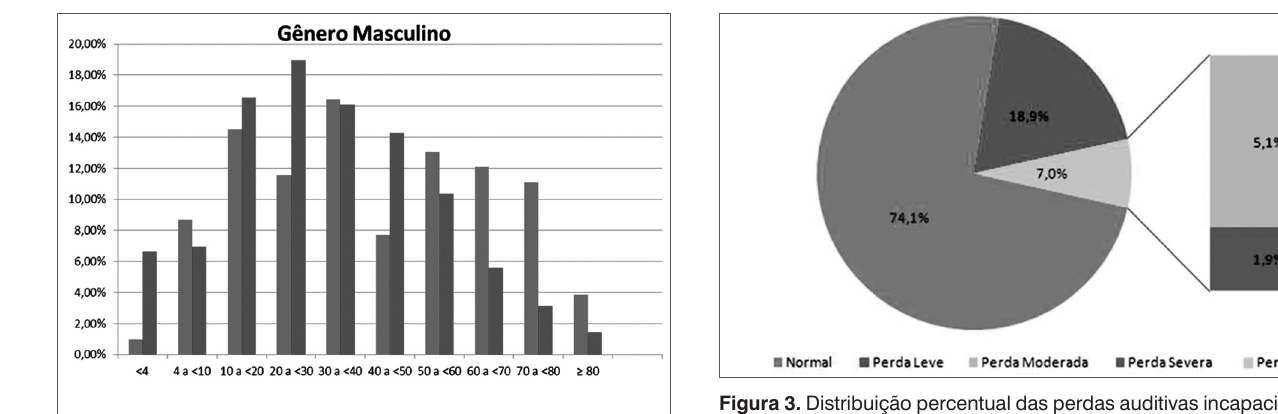
Figura 3. Distribuição percentual das perdas auditivas incapacitantes nos indivíduos em que foi realizada audiometria tonal, Itajaí, SC, Brasil,